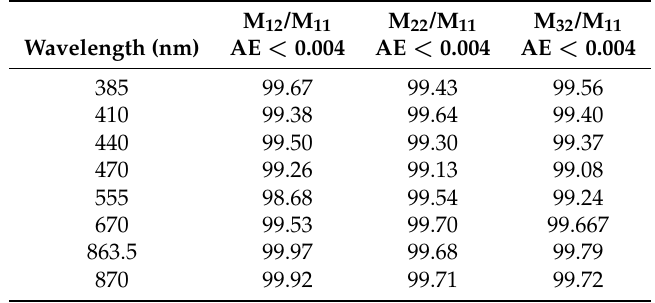
Table 3. Percentage of cases for elements M 12 /M 11 , M 22 /M 11 , and M 32 /M 11 with Absolute error (AE) less than 0.004.